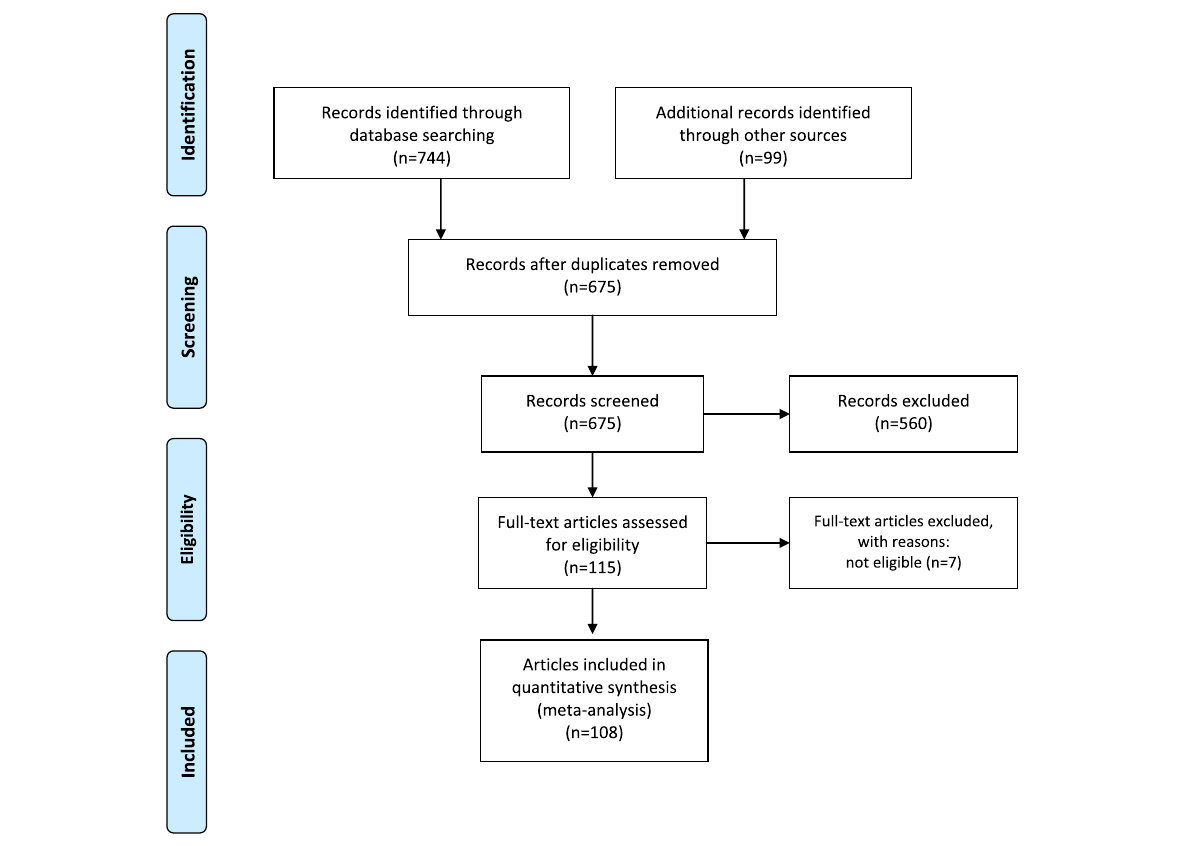
Fig. 1 PRISMA flow diagram of the literature screening